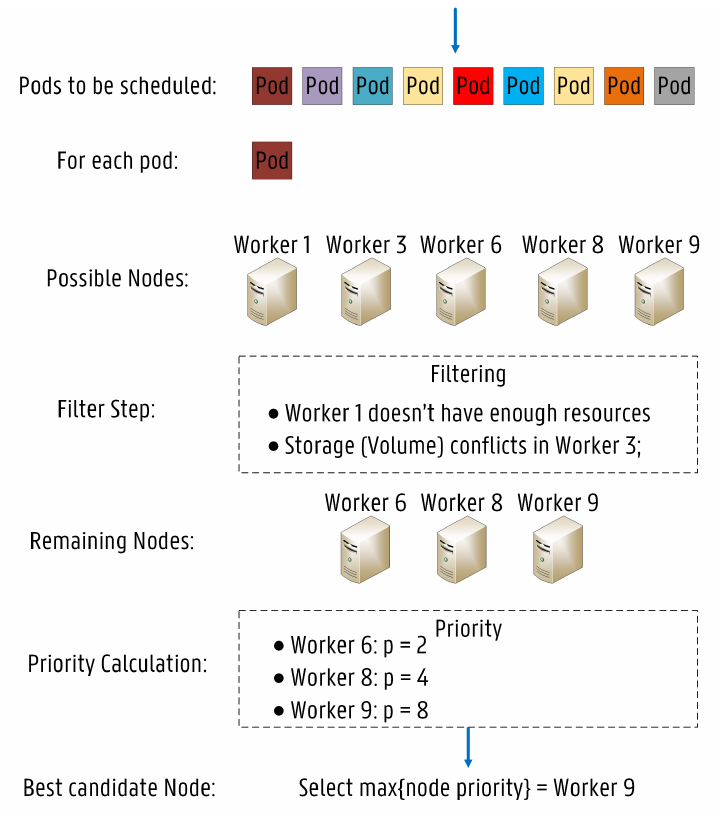
Figure 4. Sample of detailed scheduling operations of the